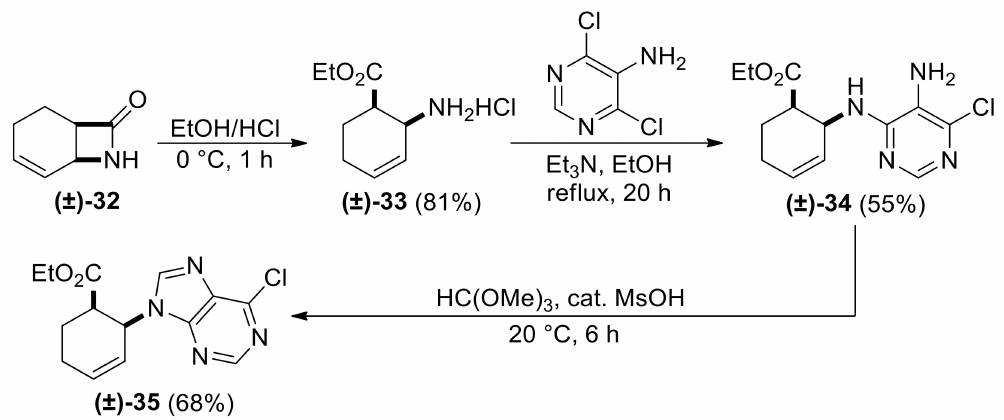
Scheme 7. Synthesis of β -amino acid-based nucleoside analog ( ± )-35 from ethyl cis -2-aminocyclohex- 3-enecarboxylate hydrochloride ( ±